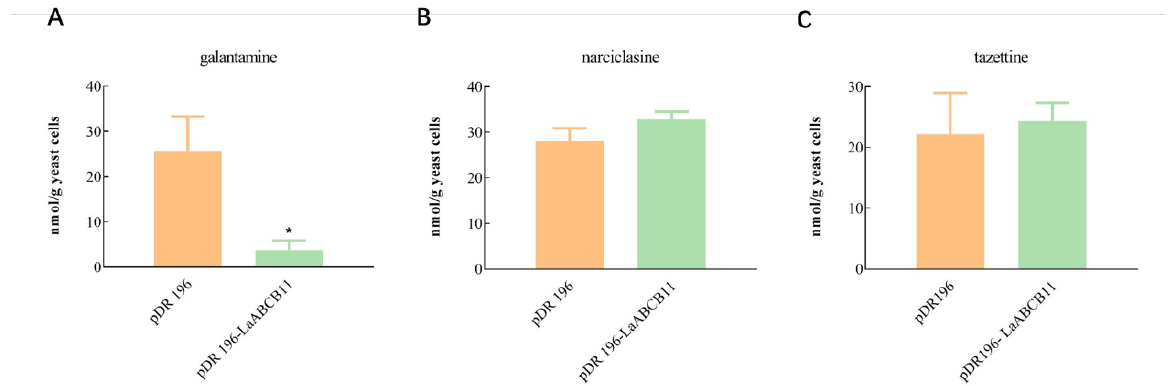
Figure 5. Substrates specificity for LaABCB11. (A) Yeast cell cultures expressing LaABCB11 or empty vector pDR196 were incubated with 30 µM ( A ) galantamine, ( B ) narciclasine, and ( C ) tazettine for 3 h. The amounts of substrate alkaloid accumulated in yeast cells were calculated. The error bars represent standard deviation from three biological replicates, and * indicates a significant difference determined by t -test ( p < 0.05), comparing with vector control.